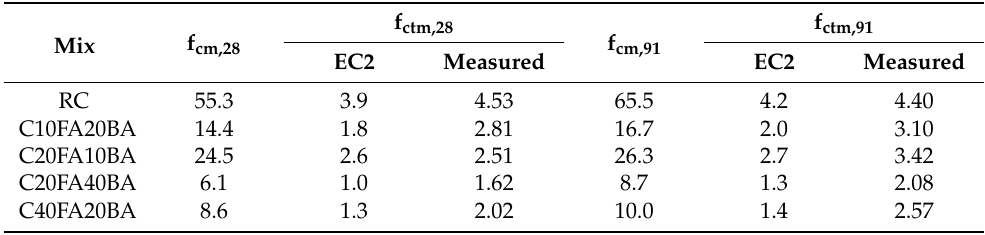
Table 5. Splitting tensile strength (f ctm in MPa) versus compressive strength (f cm in MPa) determined according to EC2 at 28 and 91 days.